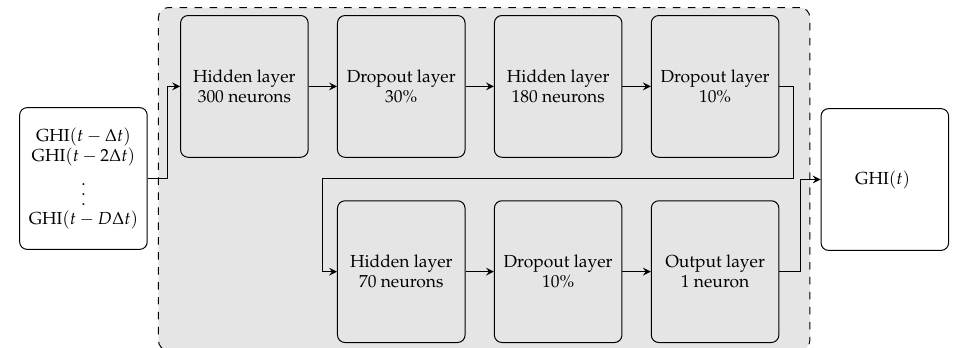
Figure 6. MLP forecasting model: the network’s topology is defined as a combination of hidden and dropout layers. The output layer provides the forecast. GHI ( t − ∆ t ) , GHI ( t − 2 ∆ t ) , . . . , GHI ( t − D ∆ t ) is the observation set and ∆ t = 10min is the time